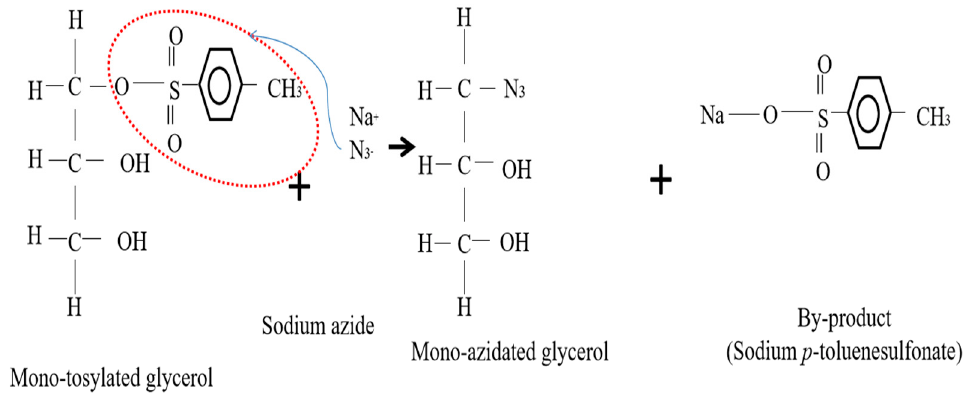
Figure 3. Azidation reaction for the production of azidated glycerol